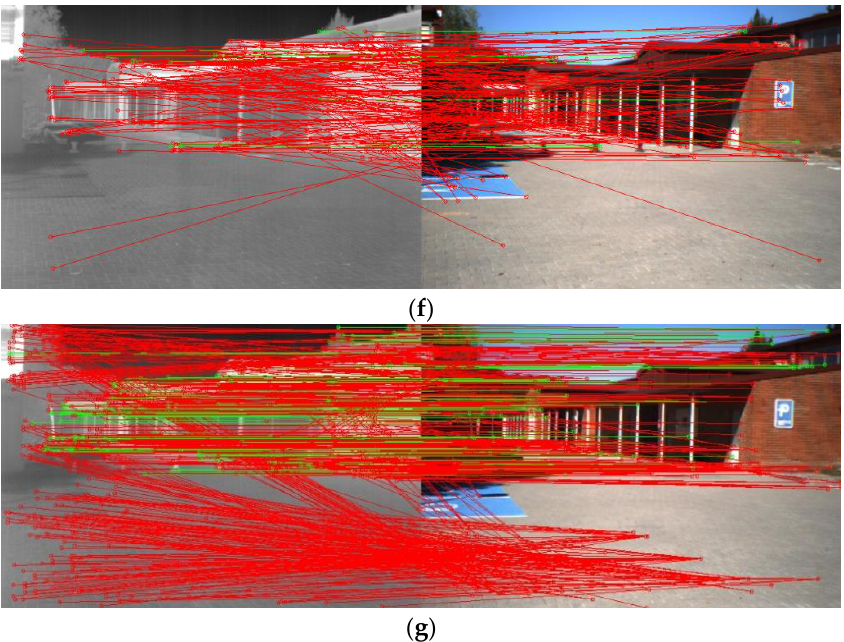
Figure 5. Matching result comparison with multi-modality image matching methods. ( a ) PIIFD, ( b ) MMSURF, ( c ) PCEHD, ( d ) LGHD, ( e ) RIFT, ( f ) MSCB, and ( g ) DDCE. Red lines indicate wrong matches and green lines indicate the correct matches.